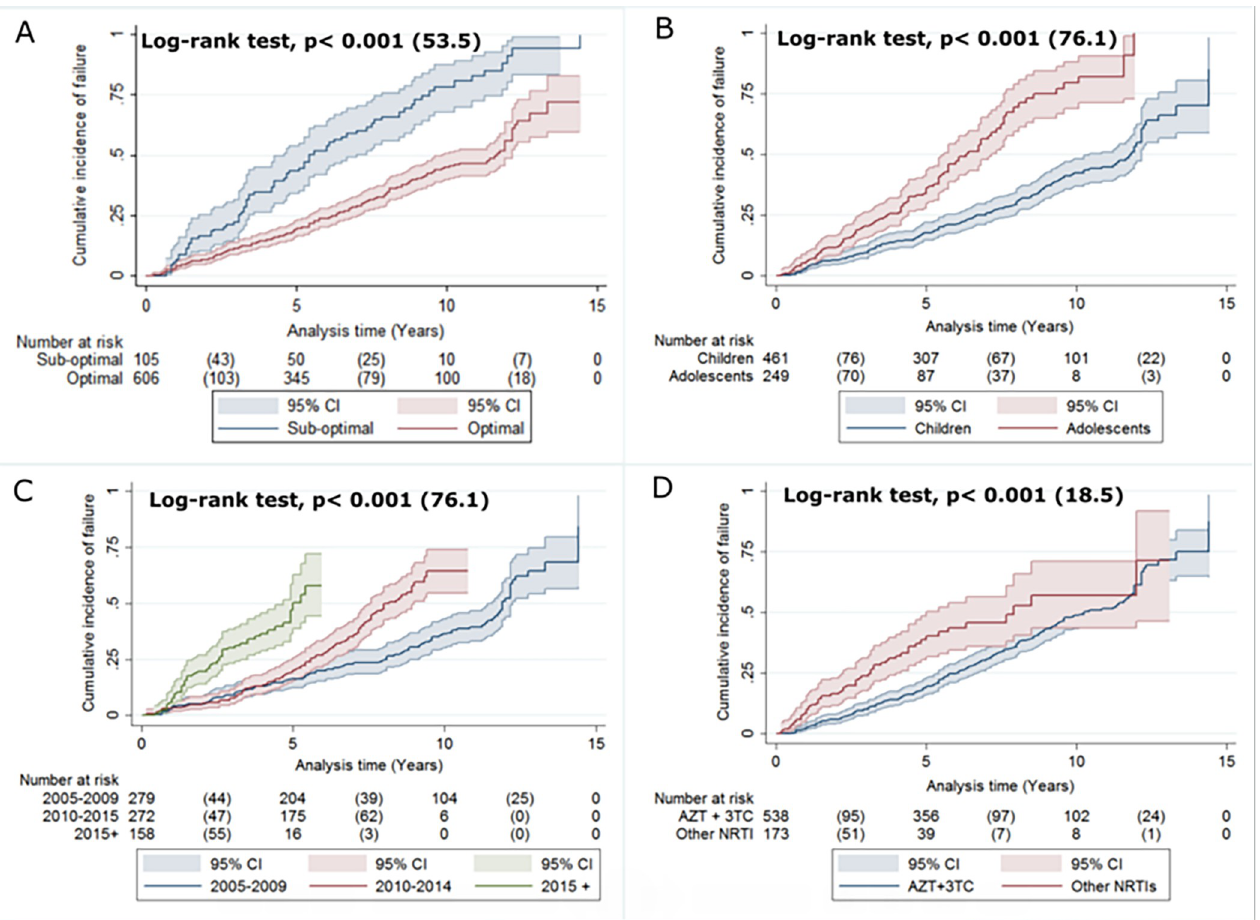
Fig 3. Kaplan-Meier cumulative incidence failure unadjusted curves for the pediatric cohort (n = 724) in National Referral Pediatric Follow-up Clinic by (A) Clinic’s record of suboptimal adherence during the entire cohort; (B) Age at cART initiation in months; (C) cART started cohort year; and (D) Initially used c ART backbone. Log-rank p-value with chi-square is used to see the significance of differences in the Kaplan-Meier failure curves. Definition: Other NRTIs: abacavir + lamivudine, stavudine + lamivudine or tenofovir + emtricitabine. Adolescents are individulas whose age is greater than 10 while children are less or equal to